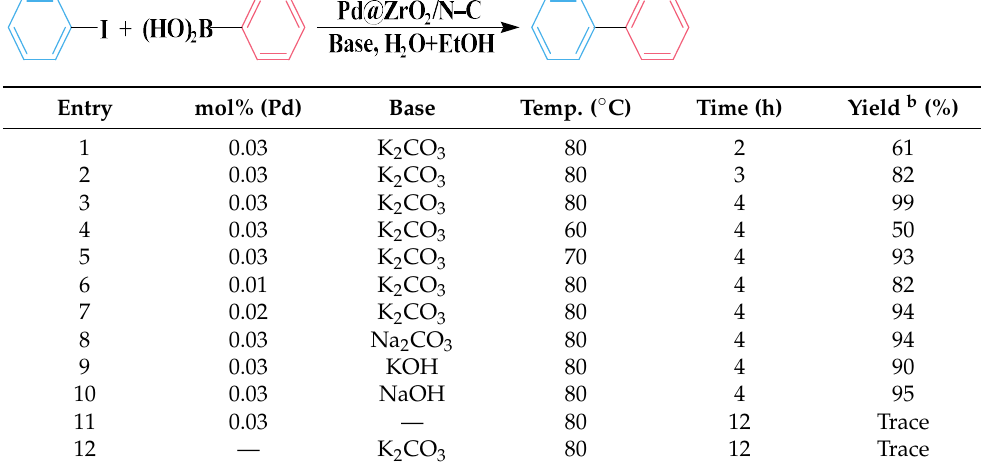
Table 1. Suzuki reactions for a wide variety of conditions with Pd@ZrO 2 /N–C a .